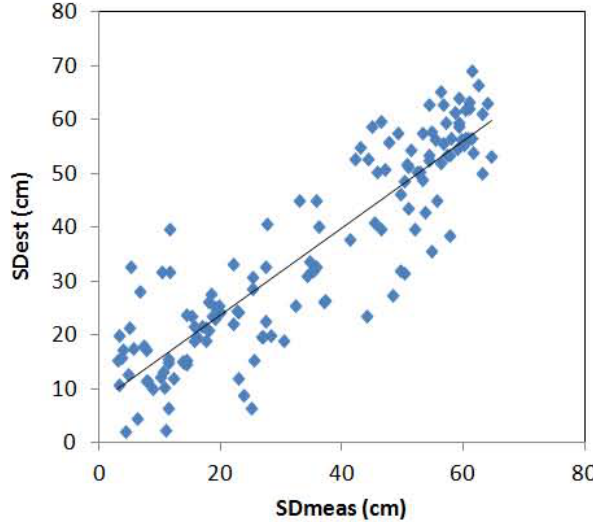
Fig. 9. Estimated vs. ground measured SD for the Siberian test area. Fig. 10. Estimated vs. ground measured SD for the test area in Scan- dinavia (Kautokeino, Sodankyla, Muonio and Pajala